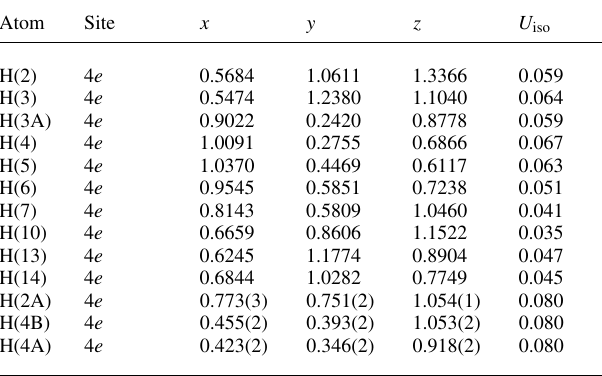
Table 2. Atomic coordinates and displacement parameters (in Å 2 )